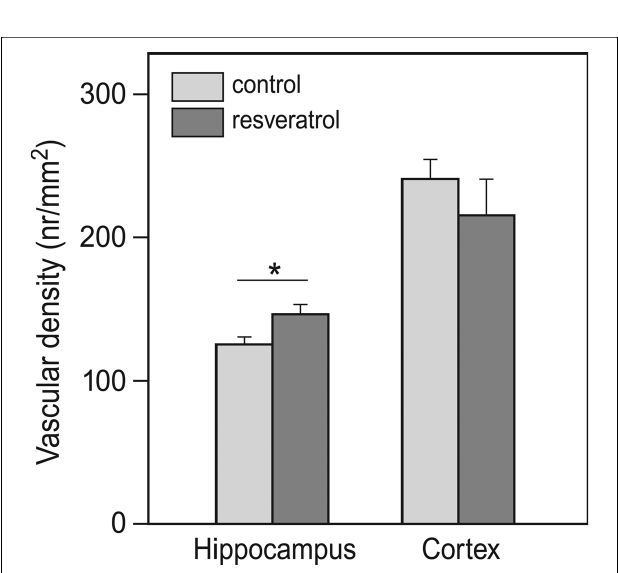
FIGURE 4 | Effects of chronic resveratrol supplementation on vascular density in the brain. In the hippocampus, resveratrol treatment caused a higher vascular density. This was not observed in the cortex (CON and RES n = 9 each) (* p =